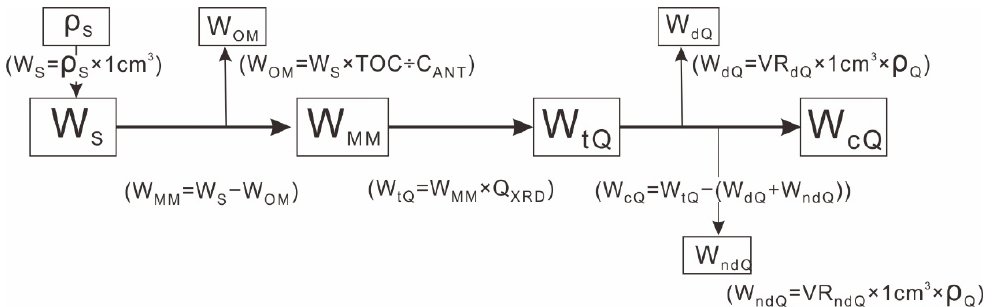
Figure 5. Calculation process of weight of clay-sized quartz in 1 cm 3 , modified after [31]. ρ S , ρ Q : shale density, quartz density (g/cm 3 ); W S : weight of 1 cm³ of shale (g); W OM : weight of organic matter (g); C ANT : carbon content of anthracite (%); W MM : weight of mineral matter (g); Q XRD : quartz content from XRD (%); W tQ : weight of total quartz in bulk shale (g); W dQ : weight of detrital quartz (g); VR dQ : volume ratio of detrital quartz (%); W ndQ : weight of non-detrital quartz (g); VR ndQ : volume ratio of non-detrital quartz (%); W cQ : weight of clay-sized quartz (g).